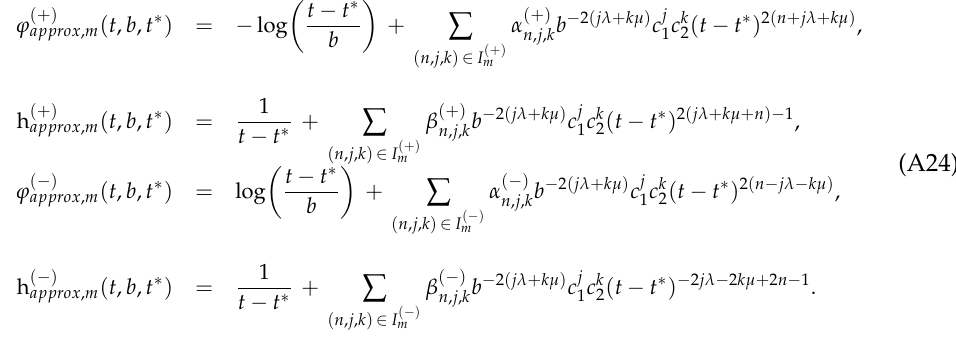
Figure A1 (resp. Figure A2) shows the 6-order approximations for ϕ (+) ( t ) and h (+) ( t ) (resp. ϕ ( − ) ( t ) and h ( − ) ( t ) ) together with the corresponding numerical solutions